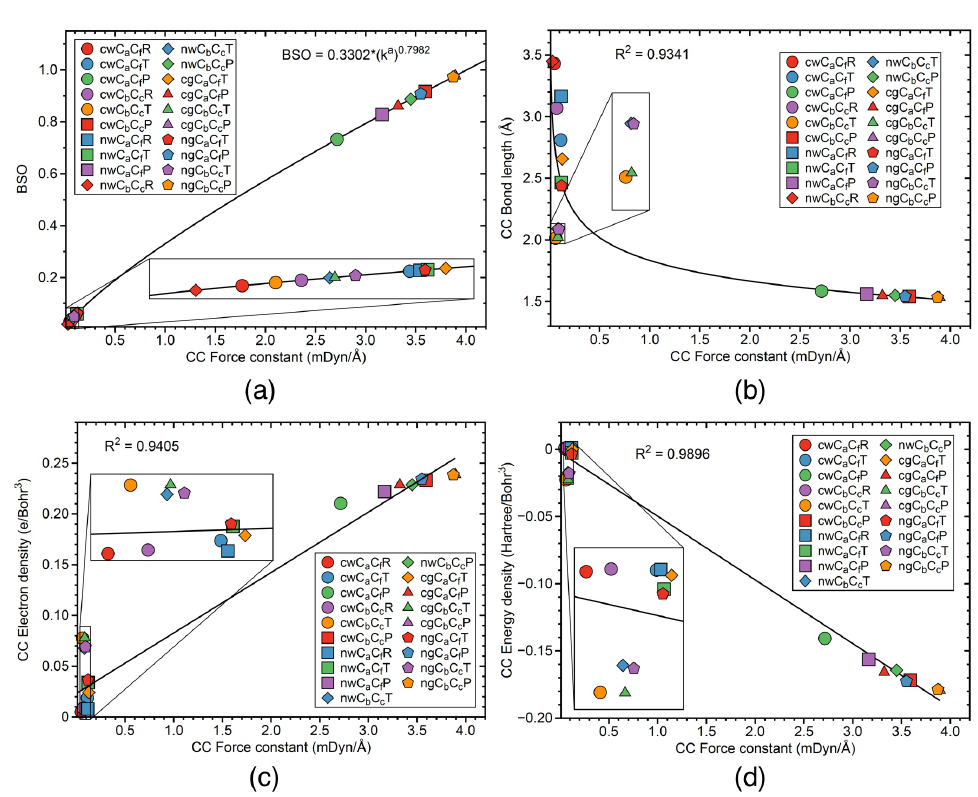
Figure 8. The C a C f and C b C c bond properties at the stationary points of the reaction R1 ; ( a ) BSO as a function of the local mode force constant; ( b ) correlation between the bond length and the local mode force constant; ( c ) correlation between the electron density at a bond critical point and the local mode force constant; ( d ) correlation between the energy density at a bond critical point and the local mode force constant. For the bond description, see the corresponding reaction plot. Re—reactant, TS—transition state, Pr—product. B3LYP/6-311+G(2d,p)/AMBER level of theory in water